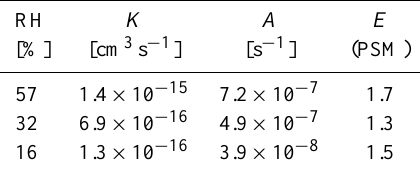
Table 6. Calculated median kinetic ( K) and activation ( A) coef- ficients at different nucleation temperatures, exponent E is taken from the linear fit to PSM data of this